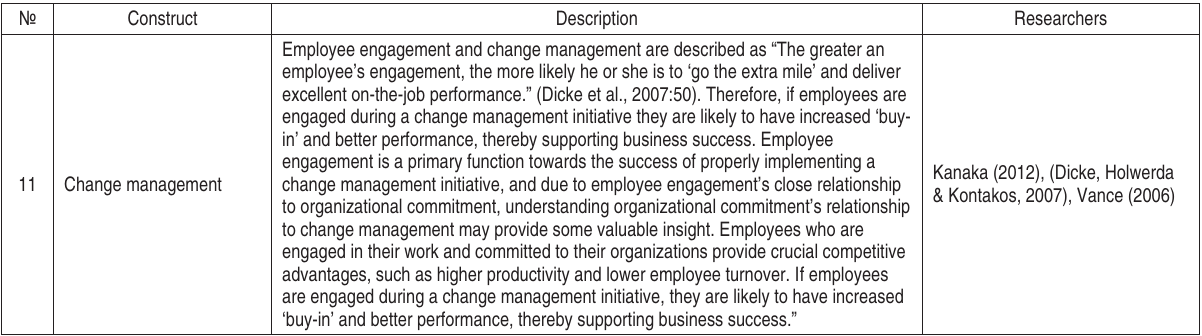
Table 1 (cont.). Employee engagement constructs